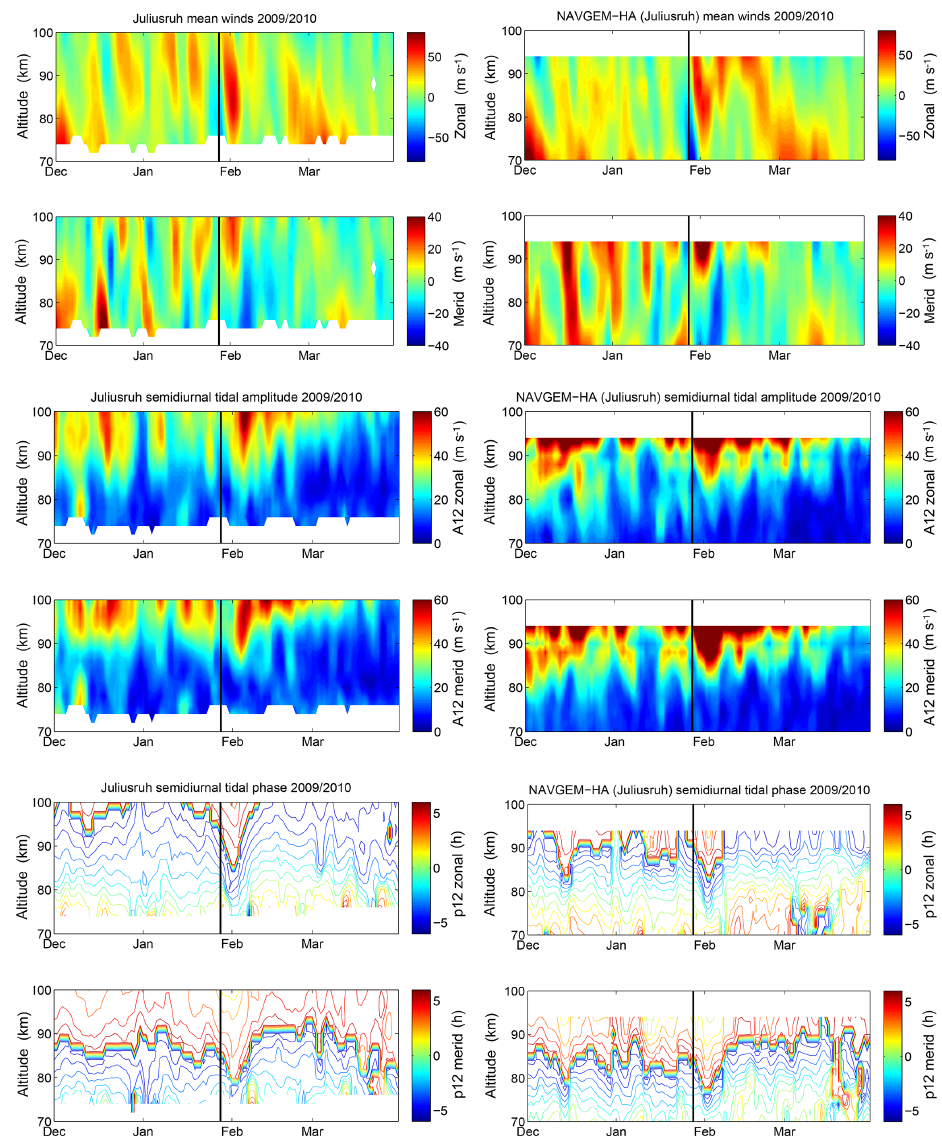
Figure 7. The same as Fig. 6 but for